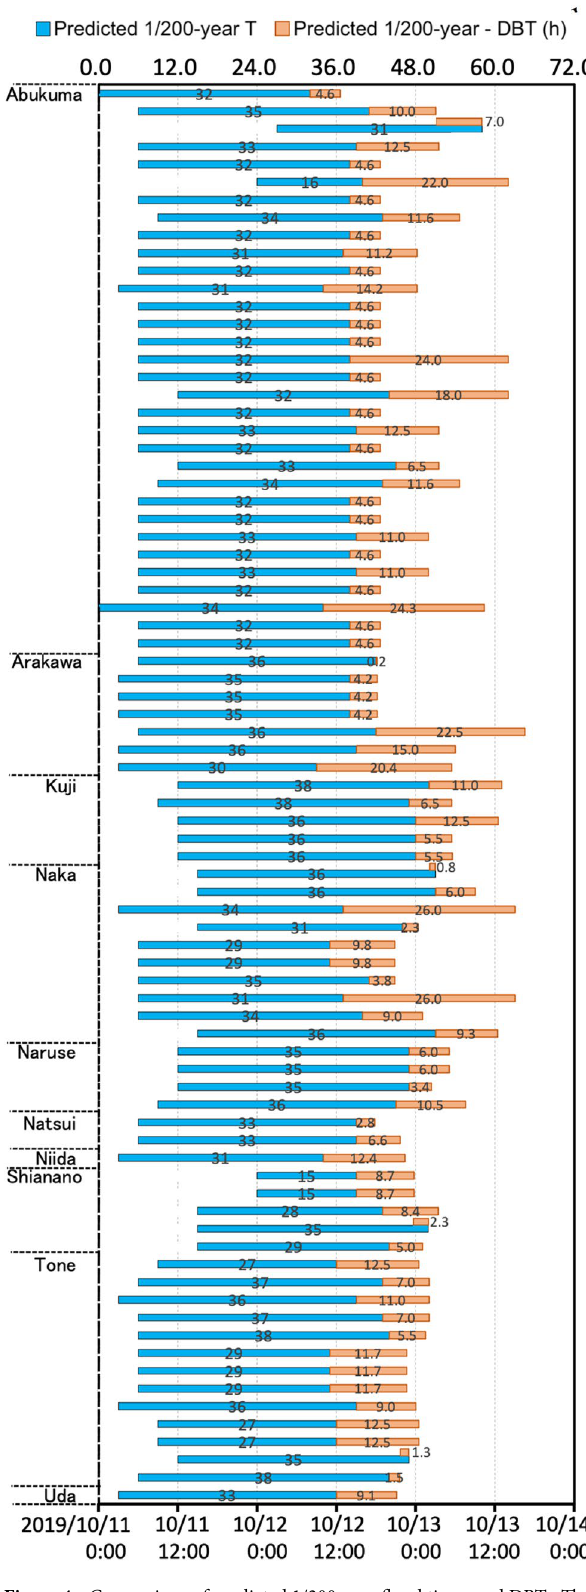
Figure 4. Comparison of predicted 1/200-year flood times and DBTs. The vertical axis shows the location of each flooded river. Each blue bar begins at the time when a 1/200-year flood was first predicted by the system. The end of each blue bar is the predicted flood time. The length of each blue bar is the lead time, which is approximately 32.75 h on average. The orange bars show differences between the DBT and the predicted 1/200-year flood time. The average of these differences indicates that the predicted 1/200-year flood time was approximately 8.53 h earlier than the